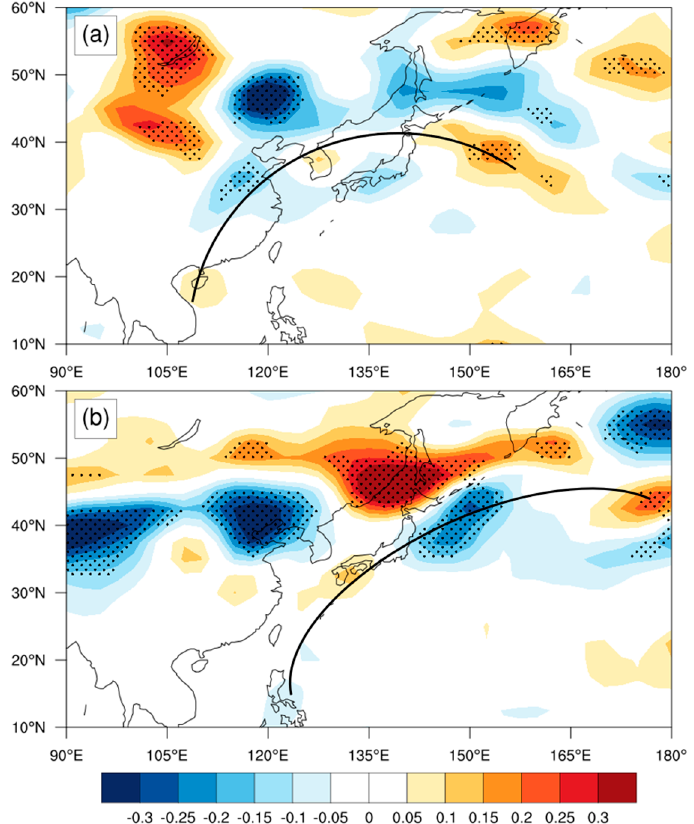
Figure 8. Composite differences of the conversion of local kinetic energy (CK) vertically integrated from 1000 to 100 hPa between wet and dry years in ( a ) S1 and ( b ) S2 (dots indicate the regions exceeding 95% confidence level; black curves in ( a , b ) represent the EAP teleconnection).